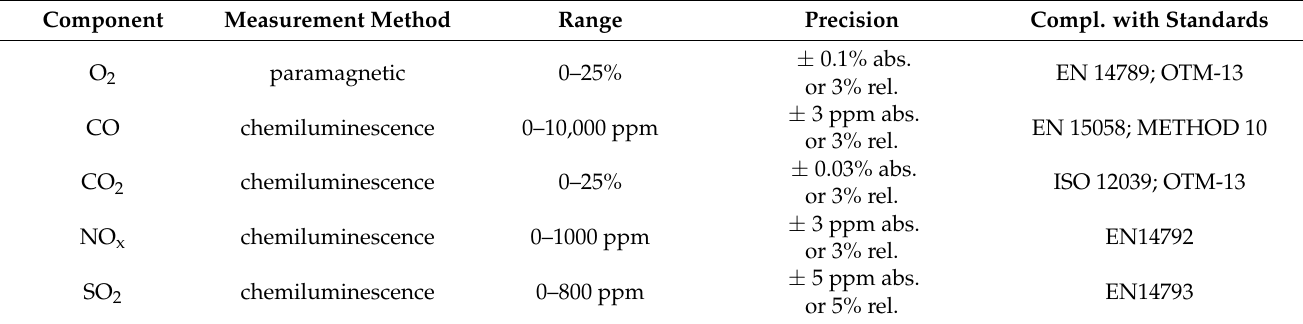
Table 5. Technical specification of the Testo 350 flue gas analyzer.